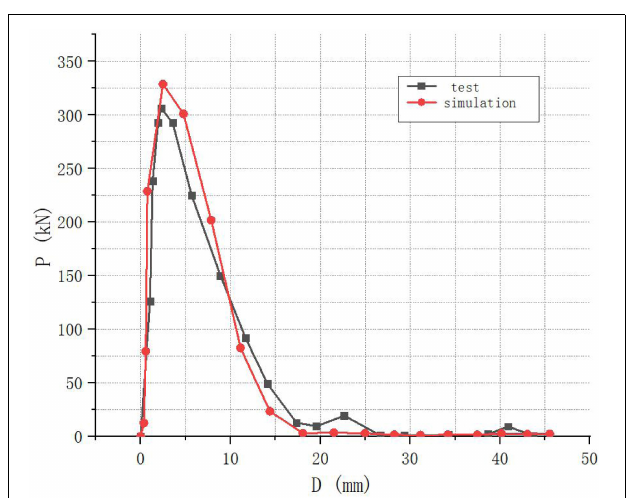
FIGURE 7 | Load-displacement curve.